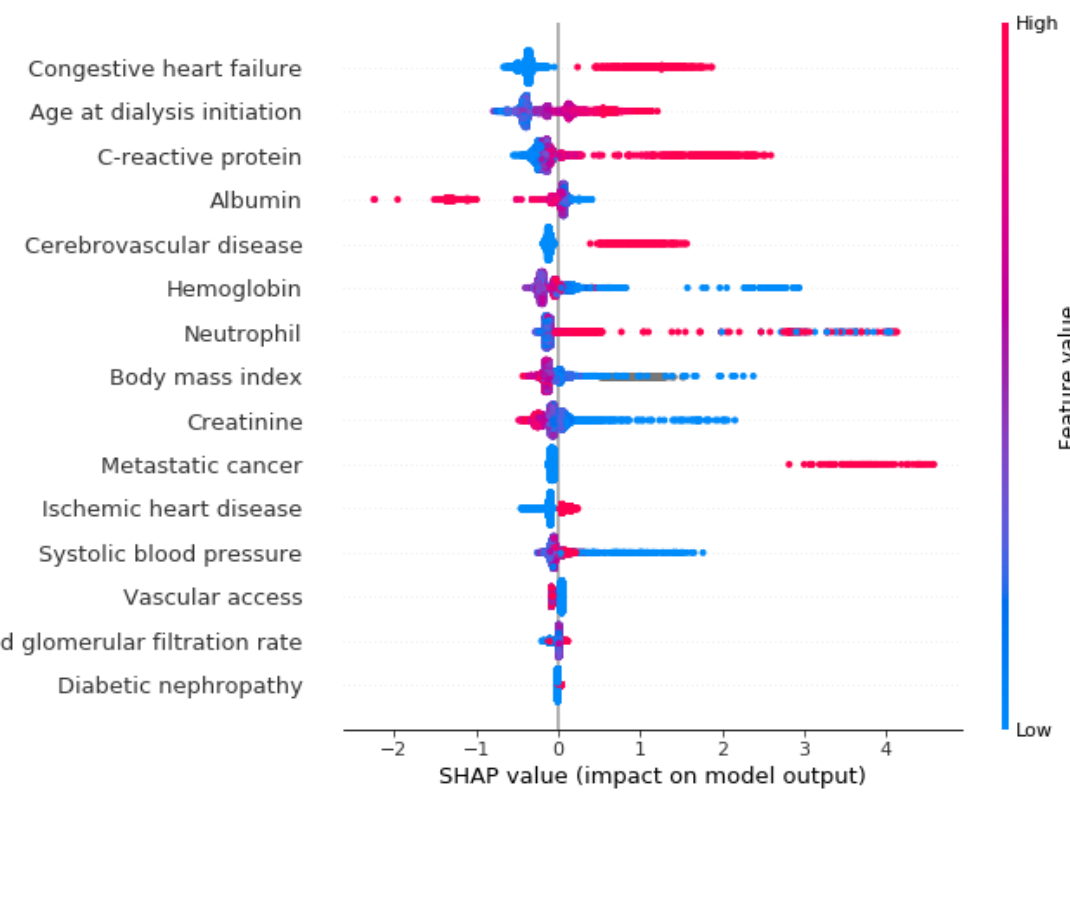
Figure 3. SHAP values illustrating how features contribute to model 1. Blue shows a negative contribution, and red shows a positive contribution. SHAP: Shapley additive